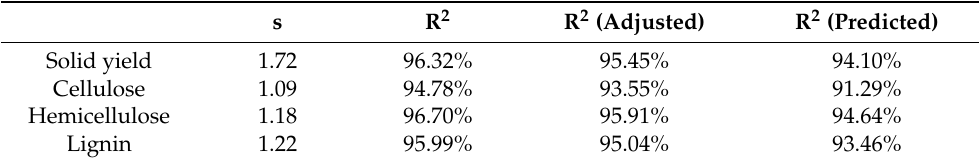
Table 7. Model summary for RMS